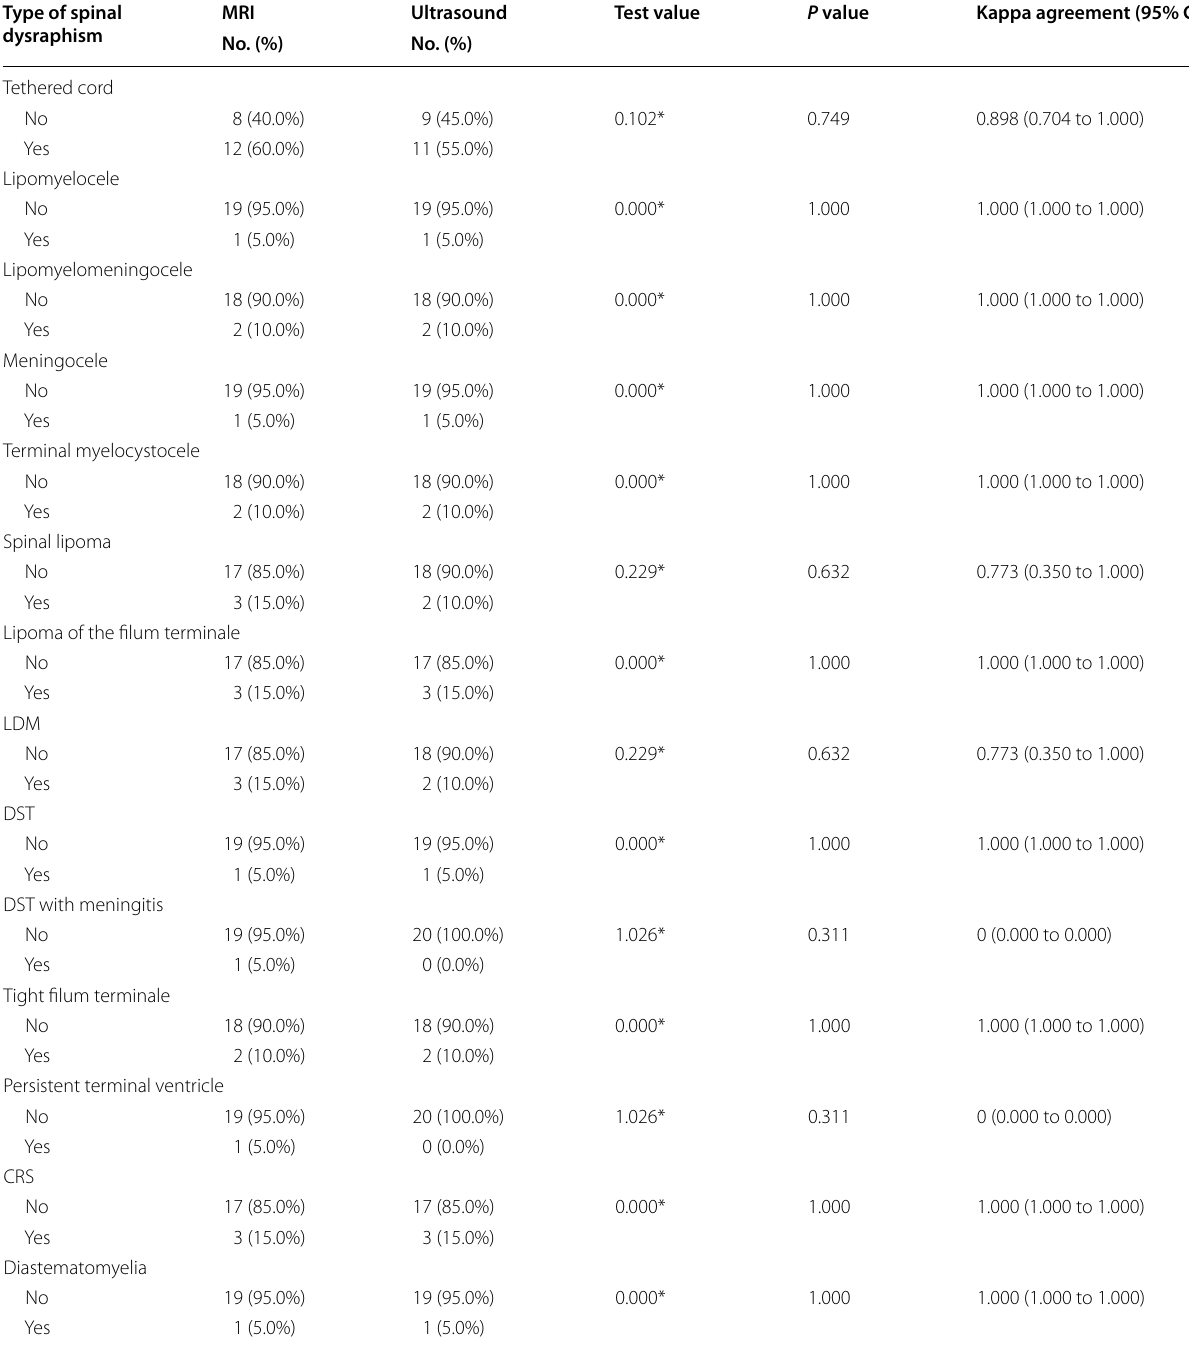
Table 5 Detailed agreement between USG and MRI findings regarding each subtype of spinal